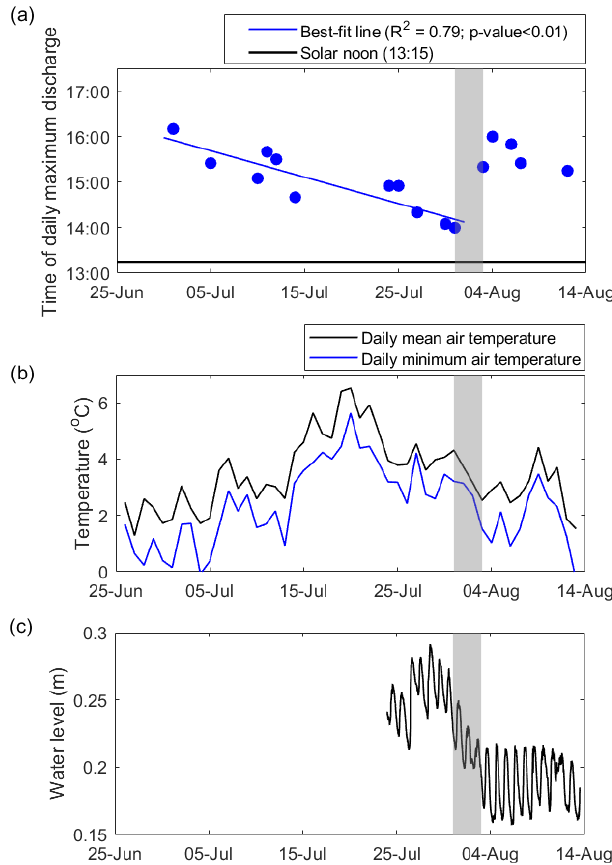
Figure 9. (a) Time to daily maximum discharge for clear-sky days. Clear-sky days were identified as days with incoming solar radiation (from KAN_L AWS data) with a smooth diurnal cycle and lacking short-term, hourly fluctuations from varying cloud cover. (b) Daily mean air temperature from KAN_L AWS. The period where change in the time of daily maximum discharge coincides with a sudden drop in temperature from 1–3 August is shown in the grey-shaded region. (c) Water level in a cryoconite hole. Measurements were made with the same type of Solinst Levelogger ® as used to measure the channel water level.